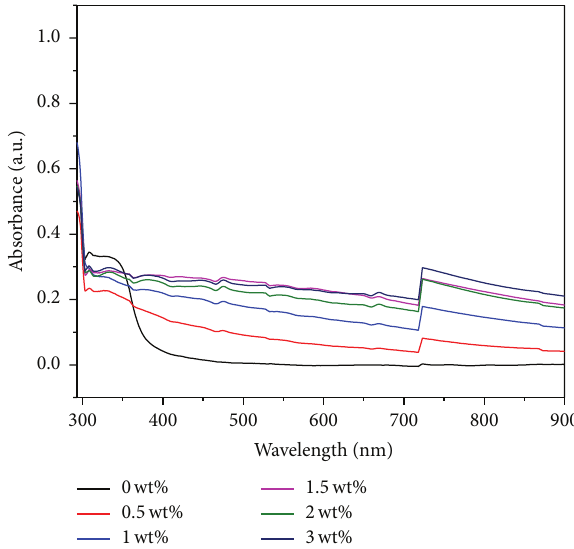
Figure 4: Absorbance of TiO 2 thin films with different wt% of carbon